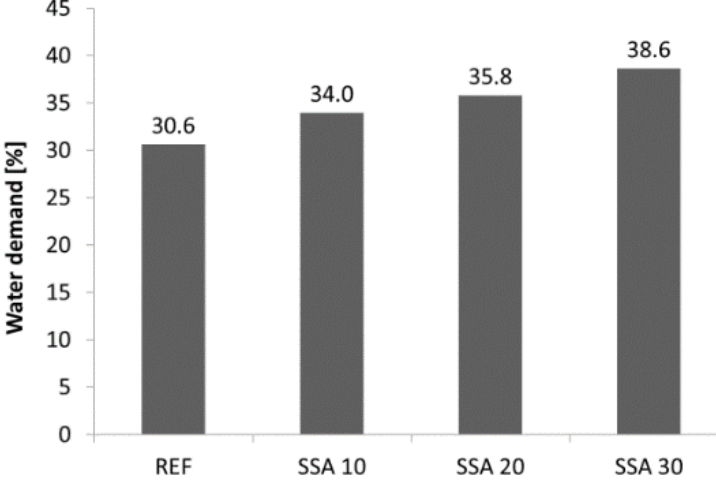
Figure 5. Water demand of the analysed binders.